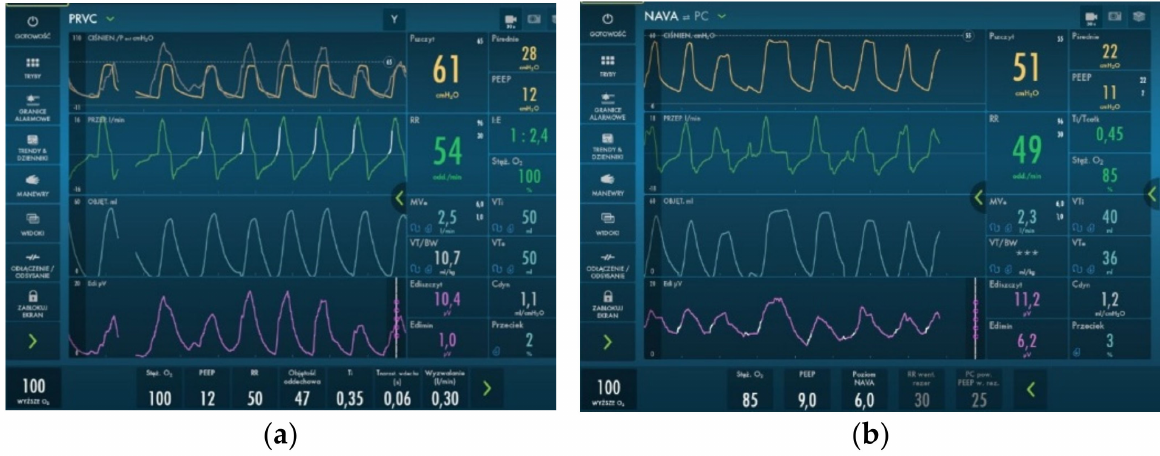
Figure 4. Invasive ventilation parameters used during hospitalization. We observed a reduction in PIP and MAP parameters after introducing NAVA ventilation. ( a ) PRVC ventilation; ( b ) NAVA